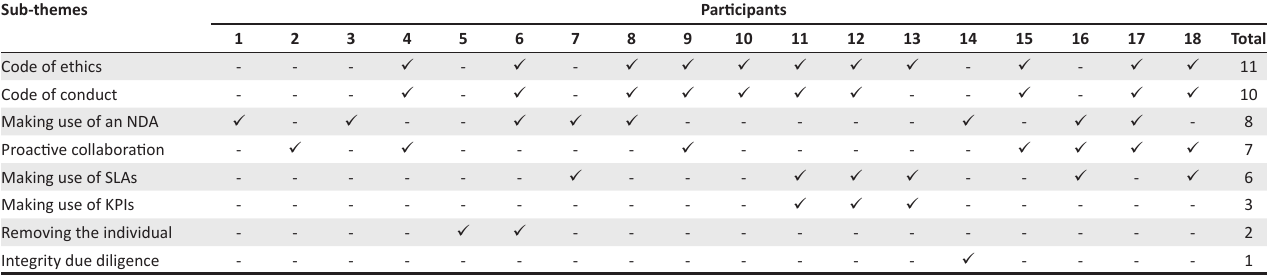
TABLE 6: Frequency of codes for information sharing risk mitigation.